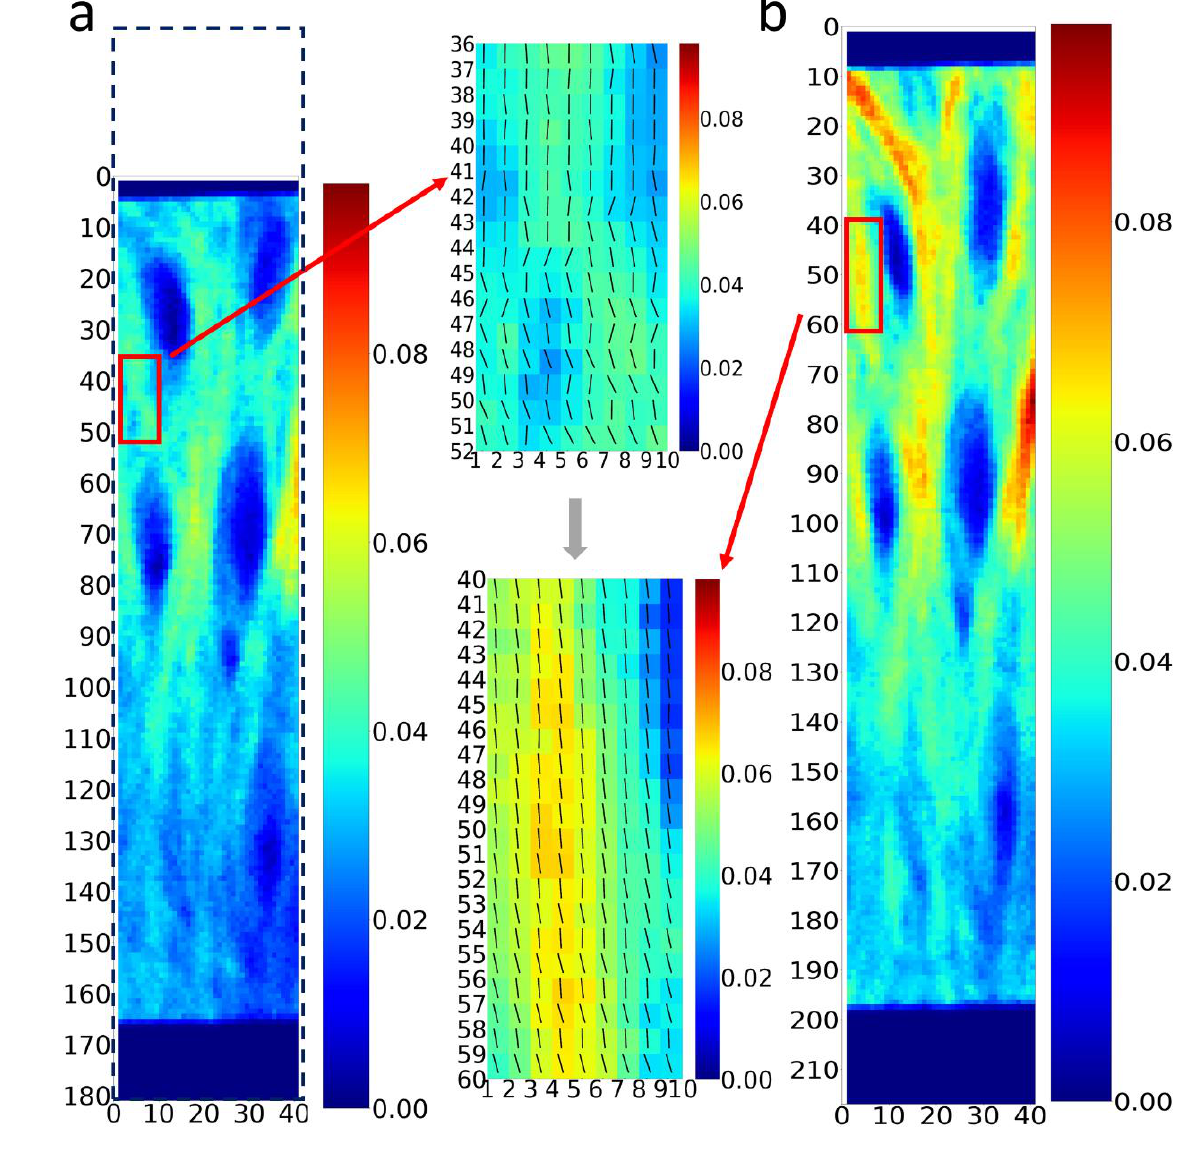
Figure 4. In situ tensile strain leads to variation of SAXS intensity contrast: ( a ) at 0% strain, collagen intensity mapping with the enlarged region of interest; dashed line is the scan size at 20% strain; ( b ) at 20% strain on same sample, collagen intensity mapping with the enlarged region of interest; ( c ) histogram of collagen D-period distribution at 0% and 20% strain; ( d ) histogram of collagen orientation angle at 0% and 20% strain. Smooth lines: kernel density estimators.